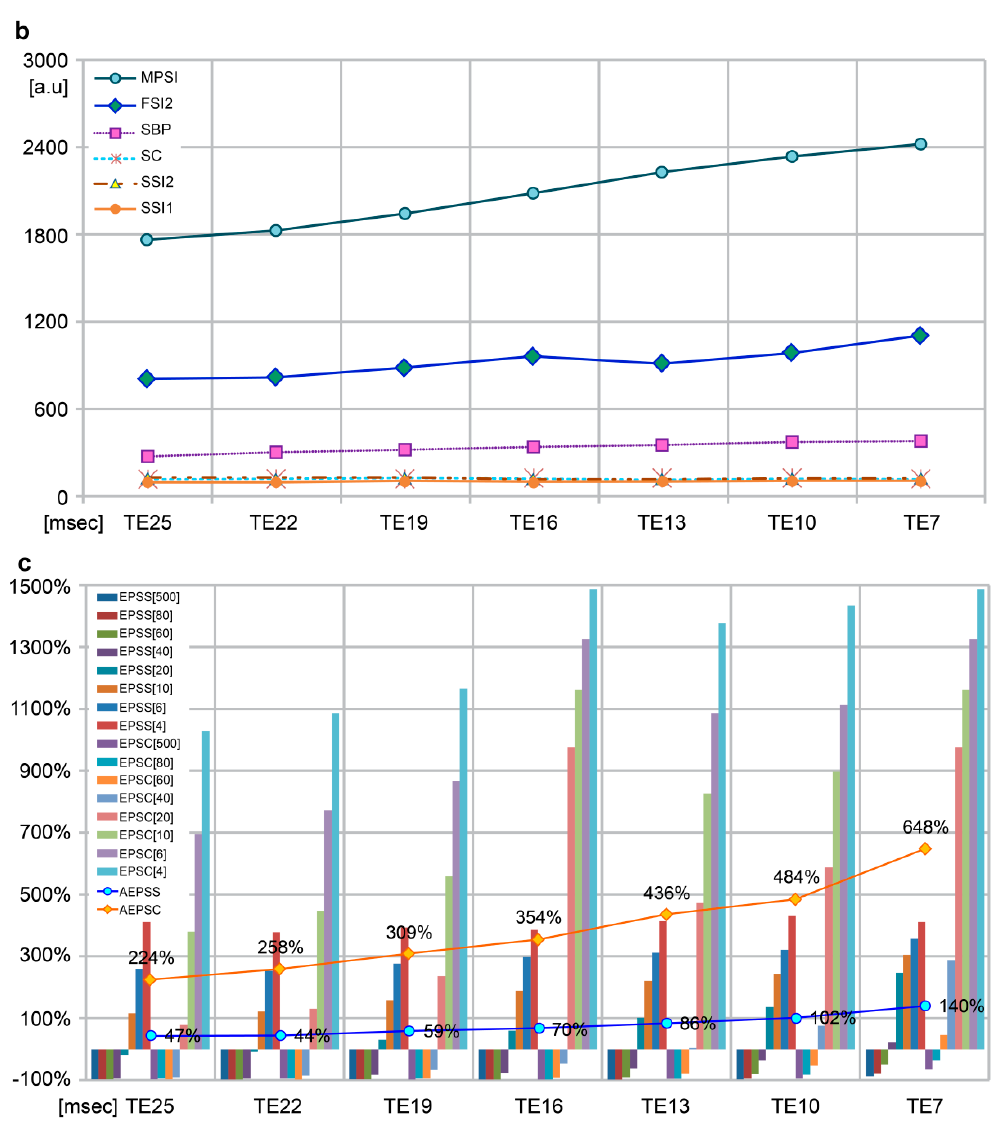
Figure 7. Graphs of SI changes in the clinical study. ( a ) changes in SI at different concentrations and ASTM by TE; ( b ) changes in SSI 1 , SSI 2 , FSI 2 , SBP, SC, and MPSI, by TE; ( c ) changes in EPSS, AEPSS, EPSC, and AEPSC by TE. SI, signal intensity; ASTM, average of SI per TE for each molar concentration; TE, echo time; SSI 1 , saline signal intensity of the phantom study, SSI 2 , saline signal intensity in the clinical phantom; FSI 2 , fat signal intensity of the second phantom, SBP, SI of brain parenchyma; SC, SI of the intraventricular cerebrospinal fluid; MPSI, max peak signal intensity; EPSS, the enhancement percentage of SI for each mol by SBP; AEPSS, average EPSS; EPSC, enhancement percentage of SI for each mol by SC; AEPSC, average EPSC.